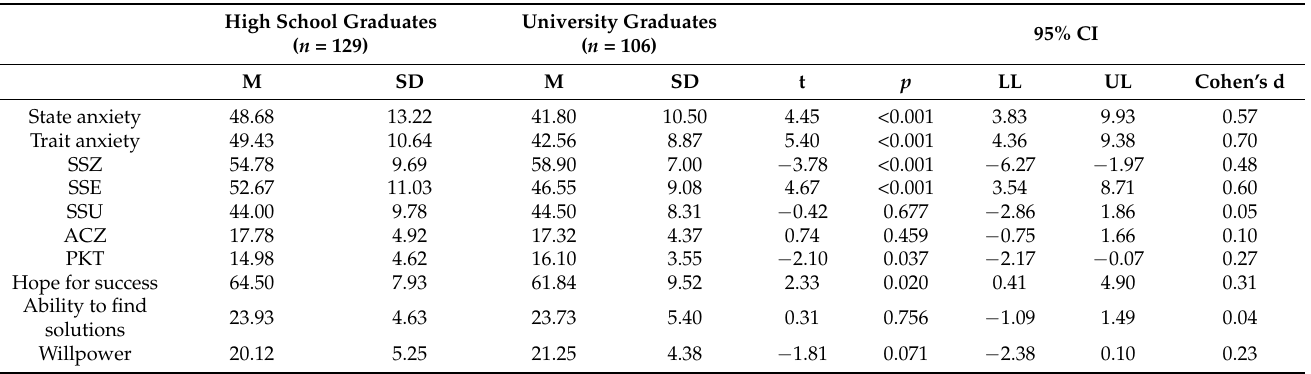
Table 1. Comparison of high school and graduate students in terms of coping styles, hope for success, and anxiety as a state and as a trait.